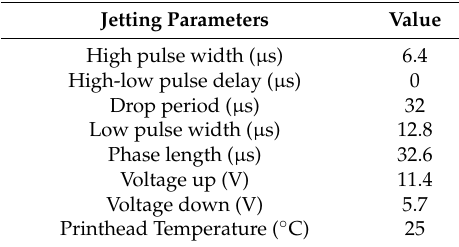
Table 2. Jetting parameters used to obtain the SDP-Y 2 O 3 films shown in Figure 3. The printhead used was a piezo 512 Konika Minolta (Chiyoda, Japan) head type M and the SDP-Y 2 O 3 precursor ink was a 0.2 M (in yttrium) with a [DEA]/[Y] ratio of